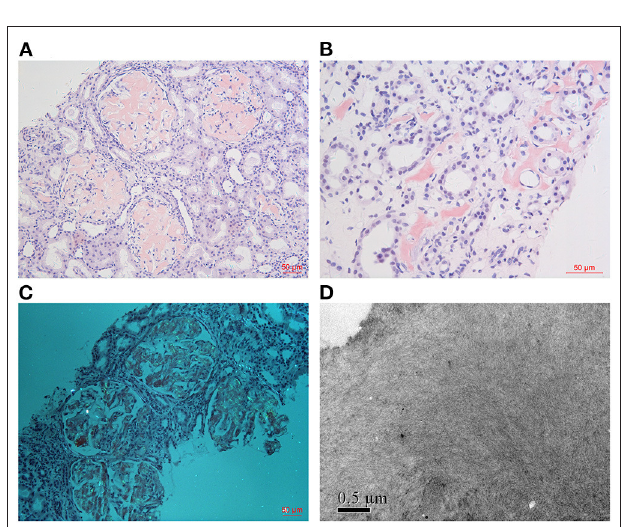
FIGURE 2 | Histology findings (take Patient 1 as an example). Massive homogeneous and Congo red positive deposits were found in glomeruli [ (A) : Congo red × 200], which produce apple green birefringence under polarized light [ (C) : Congo red × 200]. Obvious amyloid deposits were found in the renal medulla interstitium of Patient 1 [ (B) : Congo red × 400]. Electron microscopy showed randomly arranged fibrils in mesangial matrix [ (D) : EM × 40,000].